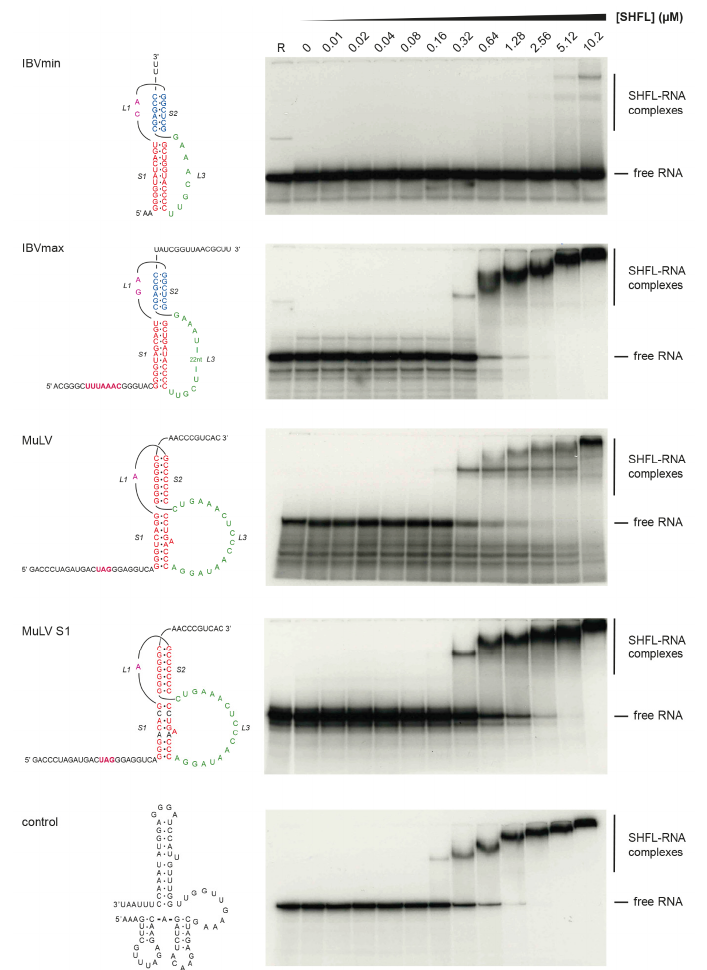
Figure 4. SHFL binds to RNA in EMSA assays. EMSA analysis of binding of SHFL to short (48-102 nt) 32 P-labeled in vitro transcripts containing a recoding signal, or a control RNA (as indicated on the left). After incubation at 37 °C for 15 min, reactions were loaded onto 10% non-denaturing polyacrylamide gels and, following electrophoresis, the gels were fixed, dried and subjected to autoradiography. The radiolabeled RNA was at 10 nM in each reaction. R represents a lane loaded with RNA only. In lanes marked 0, the RNA was incubated alone with SHFL dilution buffer (see Materials and Methods). Destabilized base-pairs in MuLV S1 are in black.